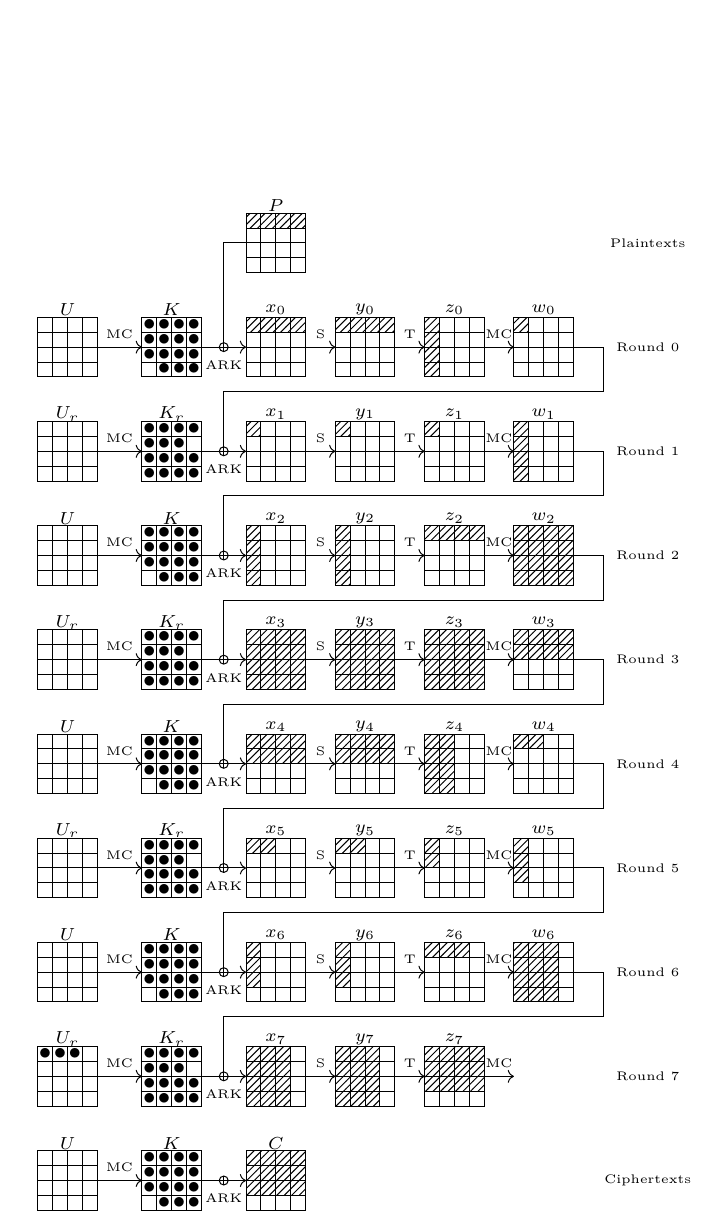
Figure 20: Full differential path used in the DS-MITM attack on 7.5-super-round Saturnin . We denote the master key 𝐾 and its rotated version (for odd rounds) 𝐾 respectively 𝑀𝐶 − 1 ( 𝐾 ) and 𝑀𝐶 − 1 ( 𝐾